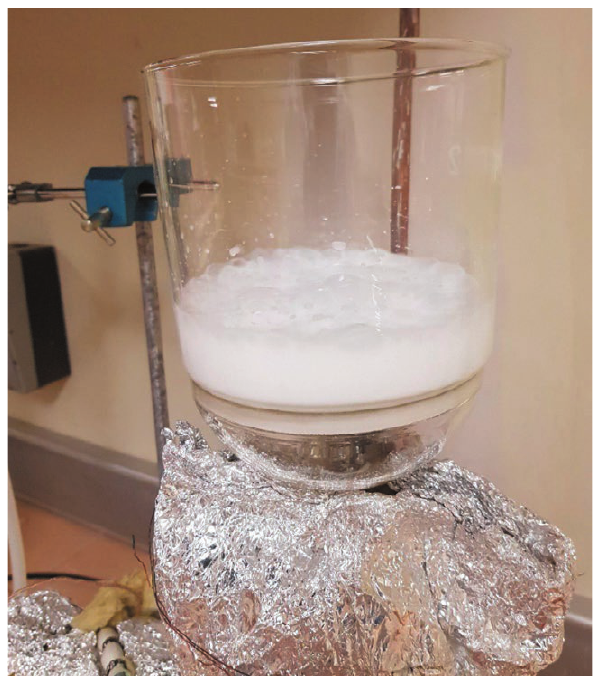
Figure 3. Photograph of the BCE process applied to 20% silica slimes using hot air.